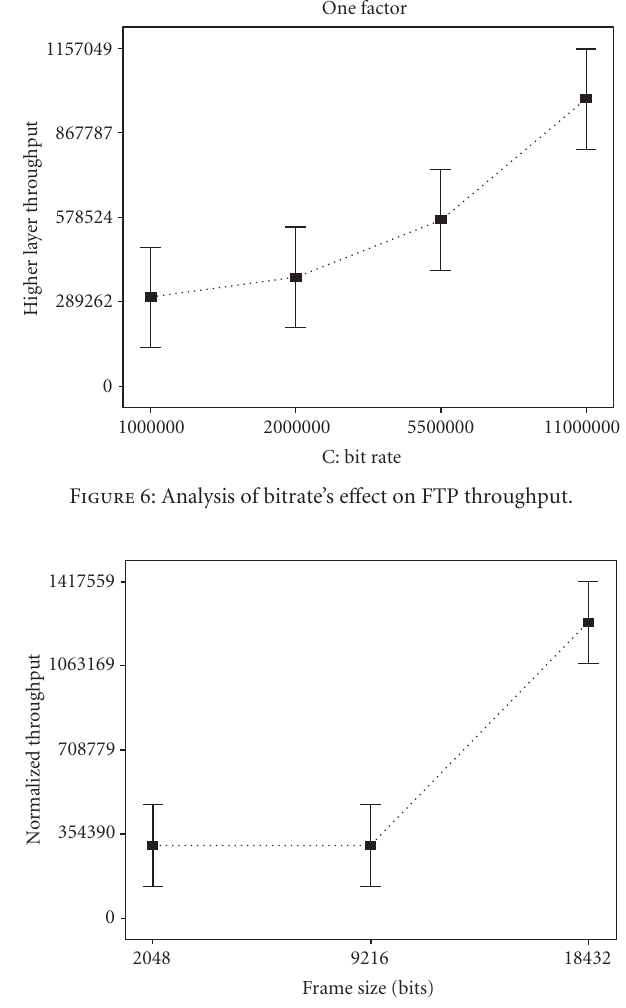
Figure 7: Analysis of frame size’s e ff ect on FTP